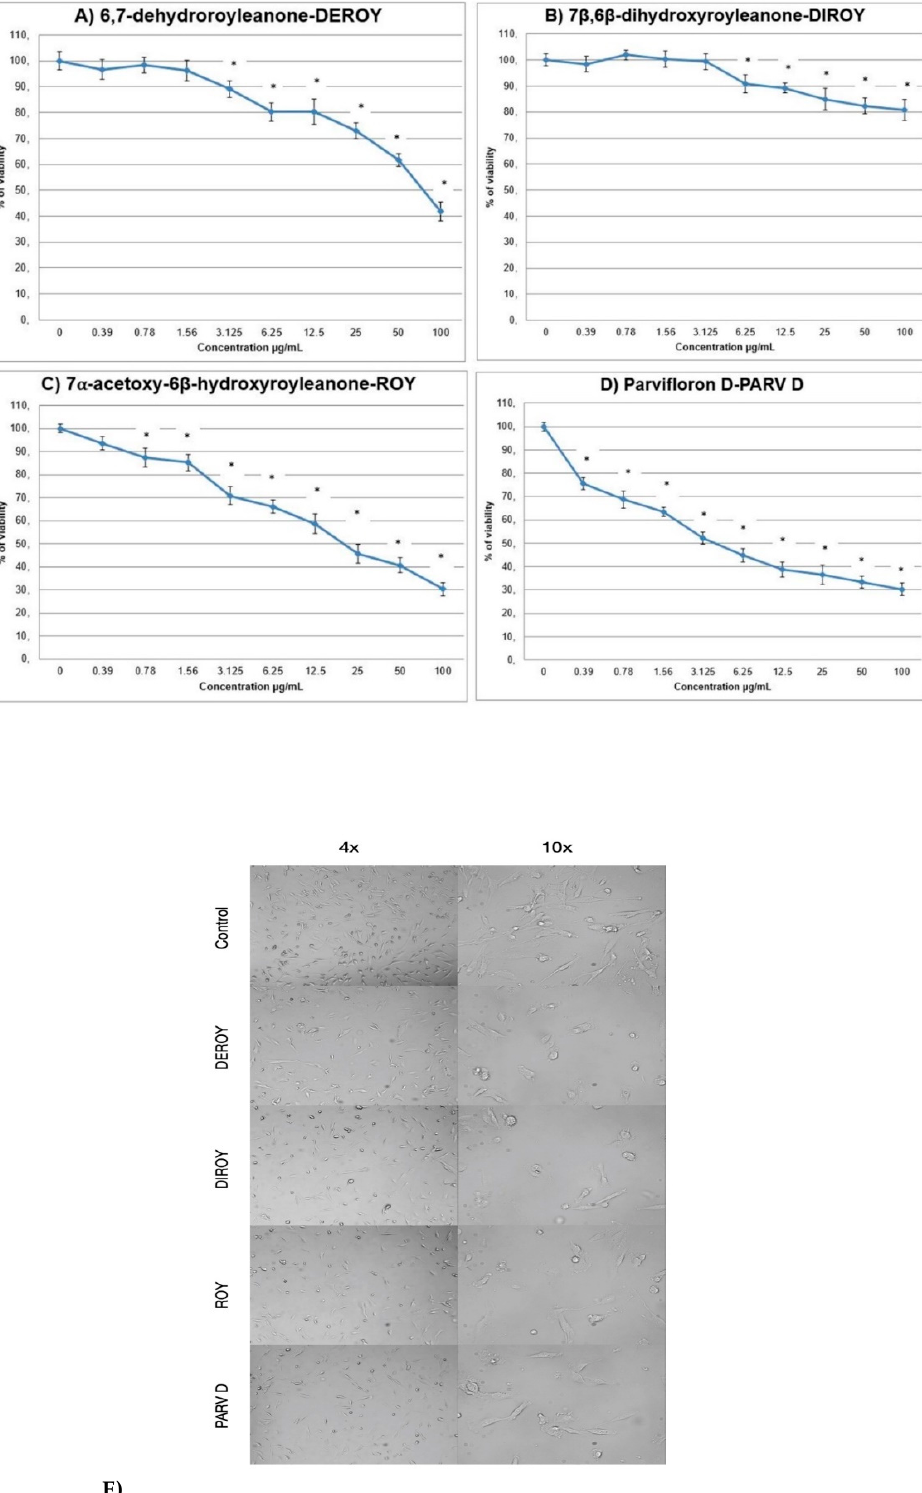
Figure 2. ( A – E ) The e ff ect of Deroy, Diroy, Roy, and Parv D treatment on cell viability after 24-h incubation. The primary H7PX glioma cells were treated with di ff erent concentrations of these compounds. The y-axis shows the percentage of cell viability. Data are reported as means ± SD of three determinations. * P < 0.05 vs untreated cells E. Representative photos showing primary H7PH glioma cells after 24 h treatment with IC50 concentrations of given compounds at di ff erent magnifications 4 × and 10 × . Photos were captured with HDCE-X5 digital microscope camera using ScopeImage9.0